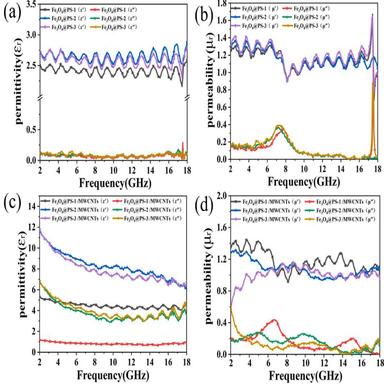
Electromagnetic parameters of Fe3O4@PS composites (a–b) and Fe3O4@PS/MWCNT composites (c–d).